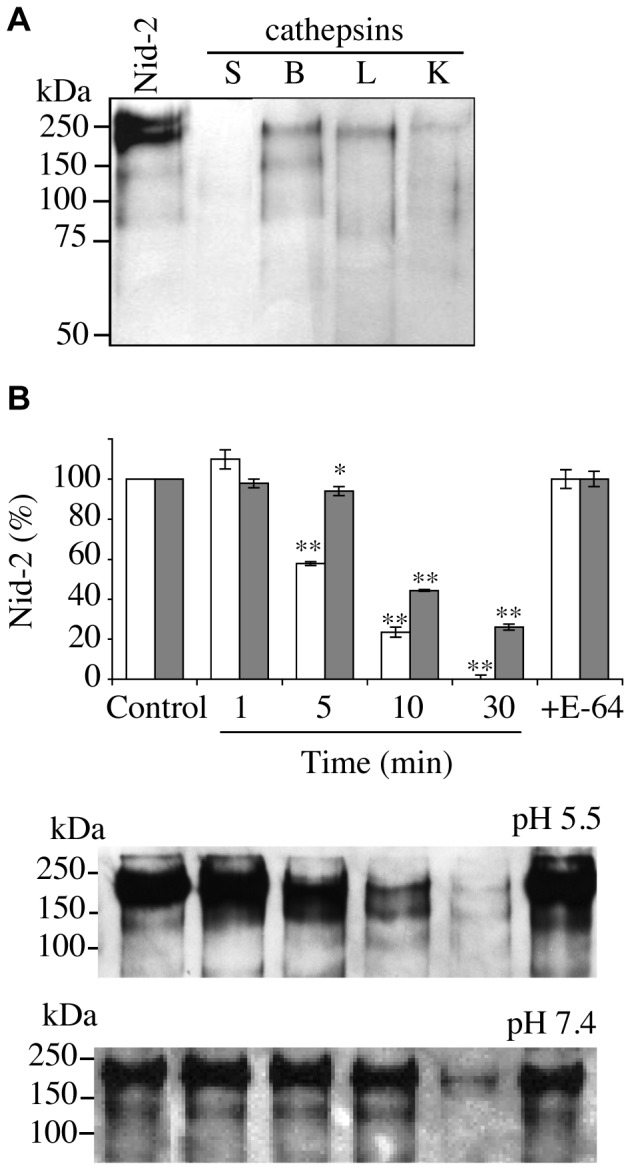
Hydrolysis of nid-2 by catS.(A) Western-blot of human nid-2 incubated with catS, catB, catL and catK at pH 5.5 for 30 min (enzyme:substrate ratio = 1∶143, w/w). (B) Densitometry analysis of nid-2 after incubation with catS (1, 5, 10, 30 min) at pH 5.5 (white bar) and pH 7.4 (grey bar). E-64 inactivated catS was used as a control. The percentage of residual nid-2 was expressed as means ± S.D (*, P<0.05 and **, P<0.01 when compared to control). A representative of three independent western blots at both pH is shown.